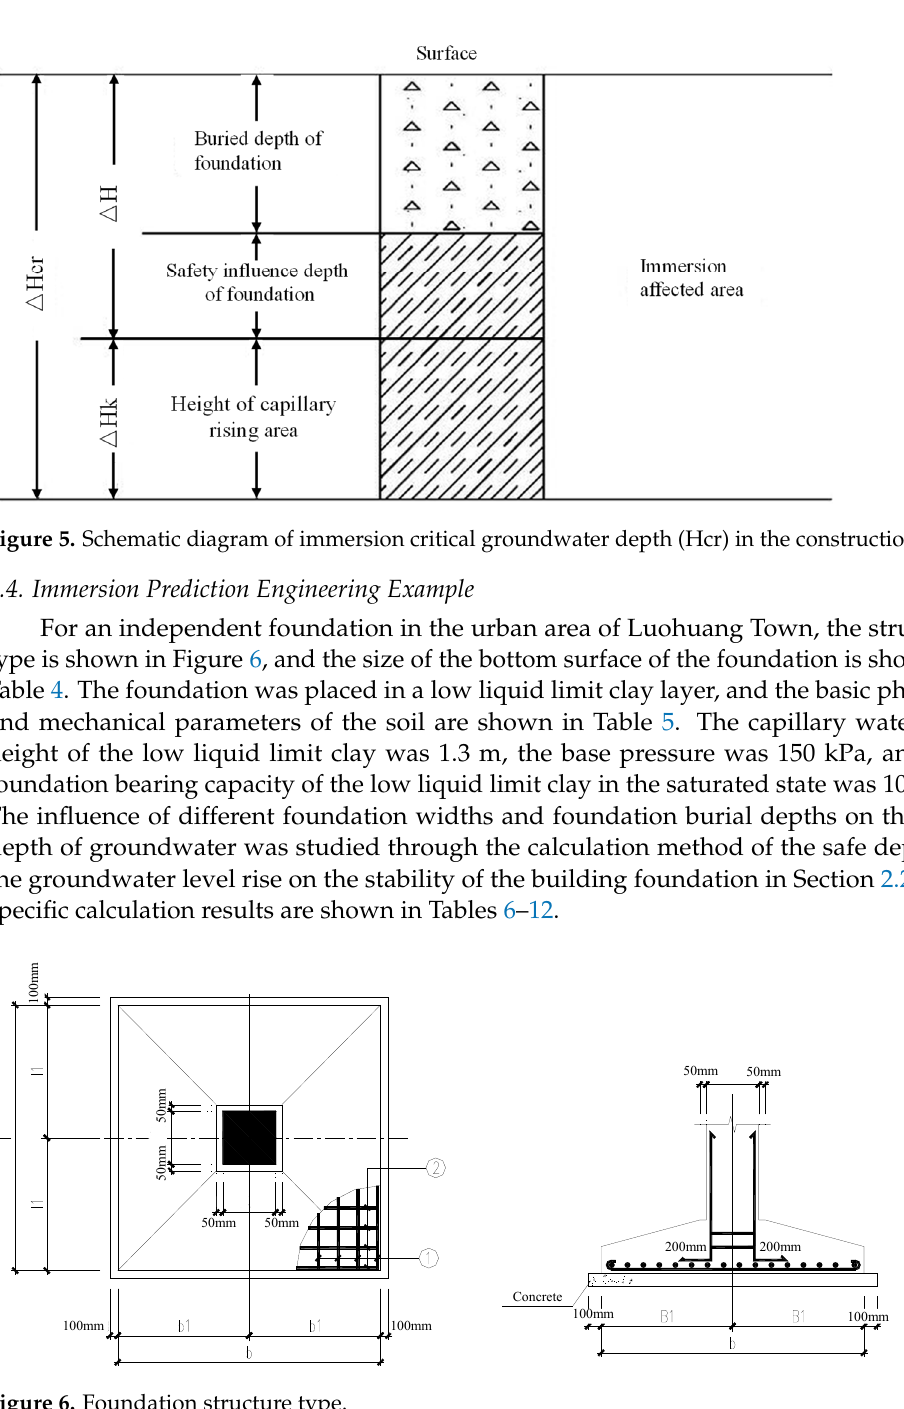
Figure 6. Foundation structure type. Table 4. Dimensions of foundation bottom.